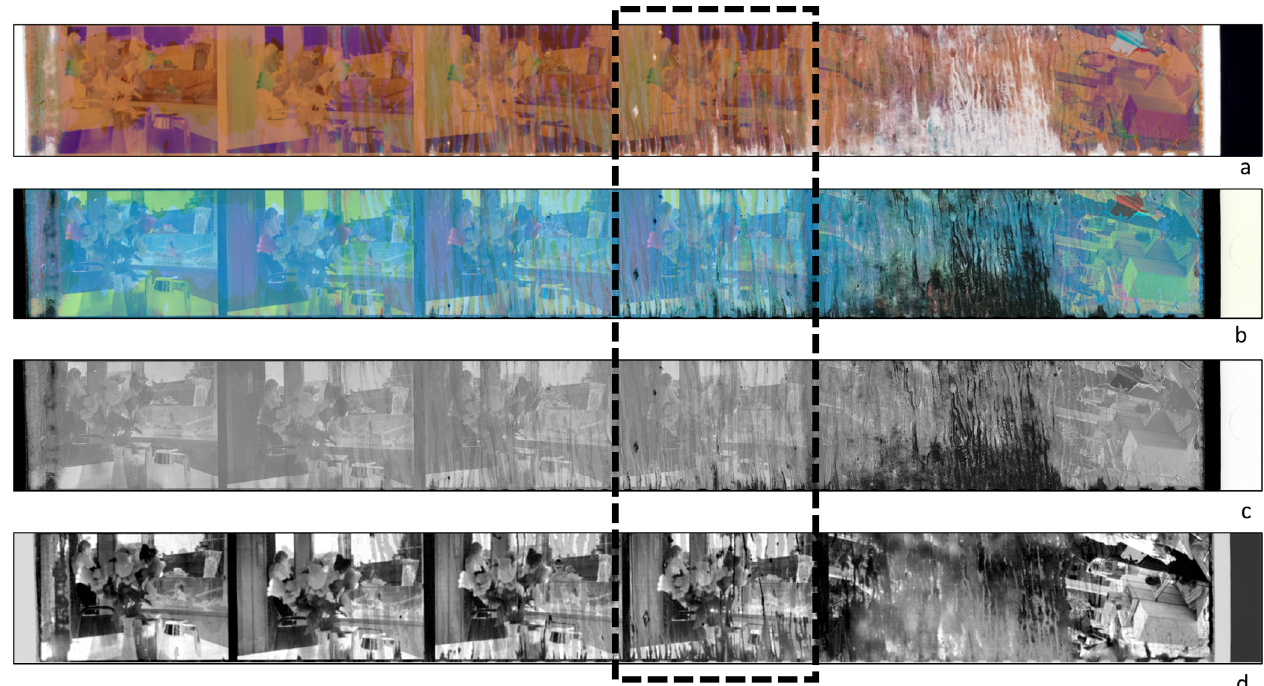
Figure 4. Elaborated HSI data set acquired on a damaged 35 mm film-strip negative Kodak Royal Supra 400 from the Dainelli archive: ( a ) sRGB image reconstructed from the HSI spectral data; ( b ) positive image obtained from the sRGB; ( c ) B&W image obtained by the positive image in greyscale. ( d ) PCA analysis in the 420–900 nm range: image PC3.